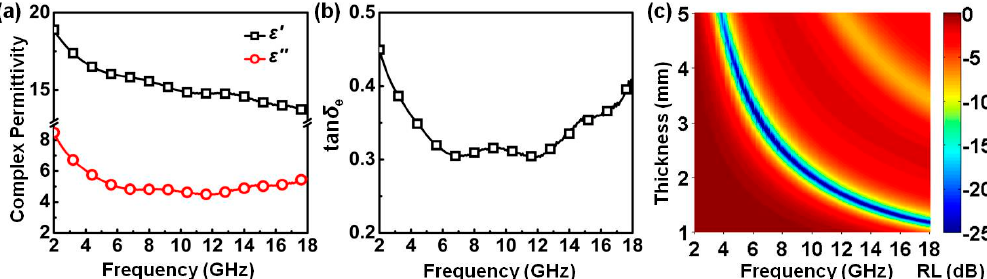
Figure 9. Complex permittivity ( a ), dielectric dissipation factor ( b ), and reflection loss properties of PPy/rGO-S2-423 K in the frequency range of 2.0 to 18.0 GHz ( c ). PPy/rGO-S2-423 K in the frequency range of 2.0 to 18.0 GHz ( c ).